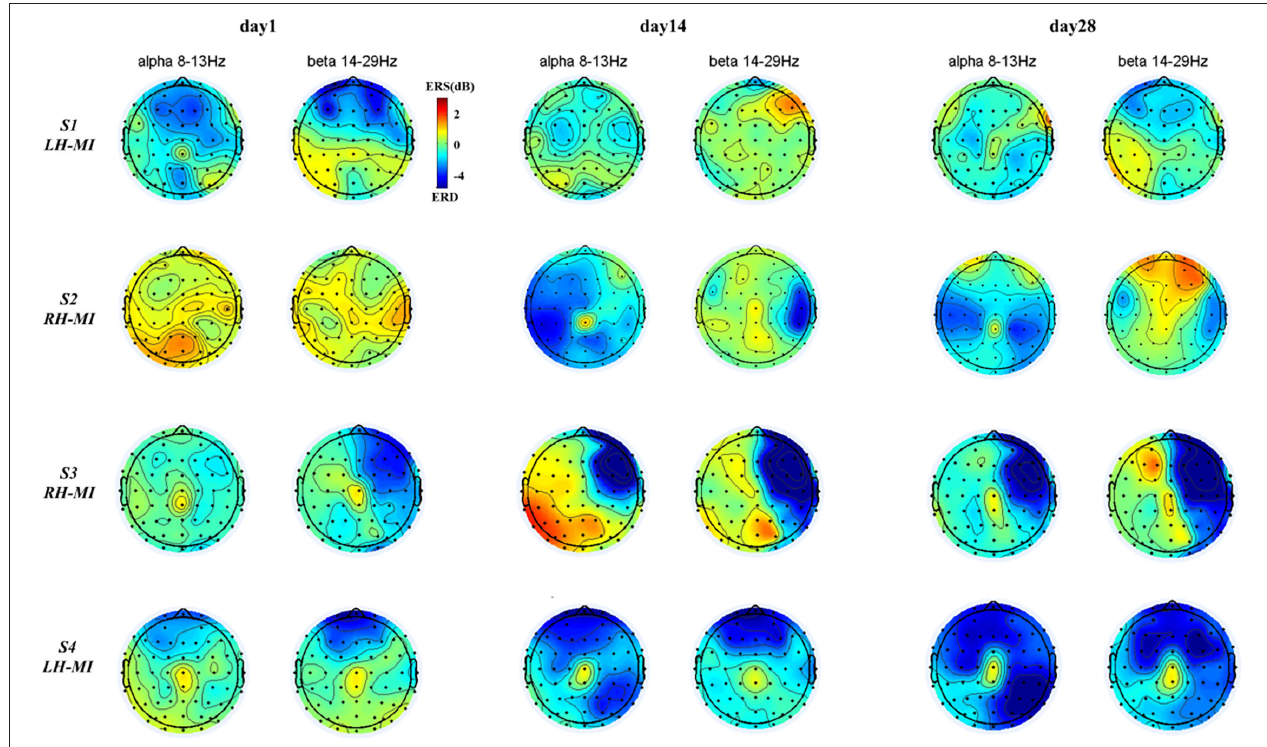
FIGURE 7 | EEG brain mapping results of the experimental group under standard assessment session in long-term rehabilitation